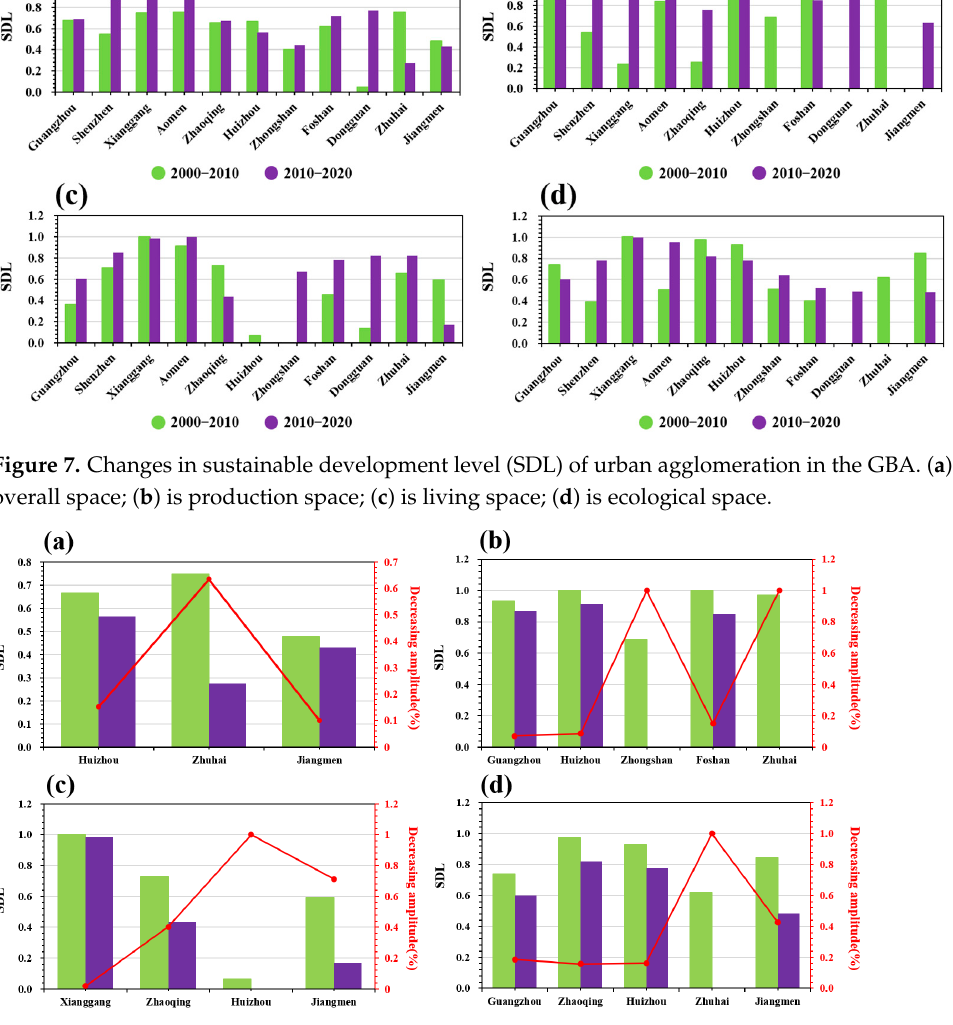
Figure 8. Comparison of areas where the sustainable development level (SDL) in the Guangdong- Hong Kong-Macao Greater Bay Area has declined and the decreasing amplitude. ( a ) is overall space; ( b ) is production space; ( c ) is living space; ( d ) is ecological space.